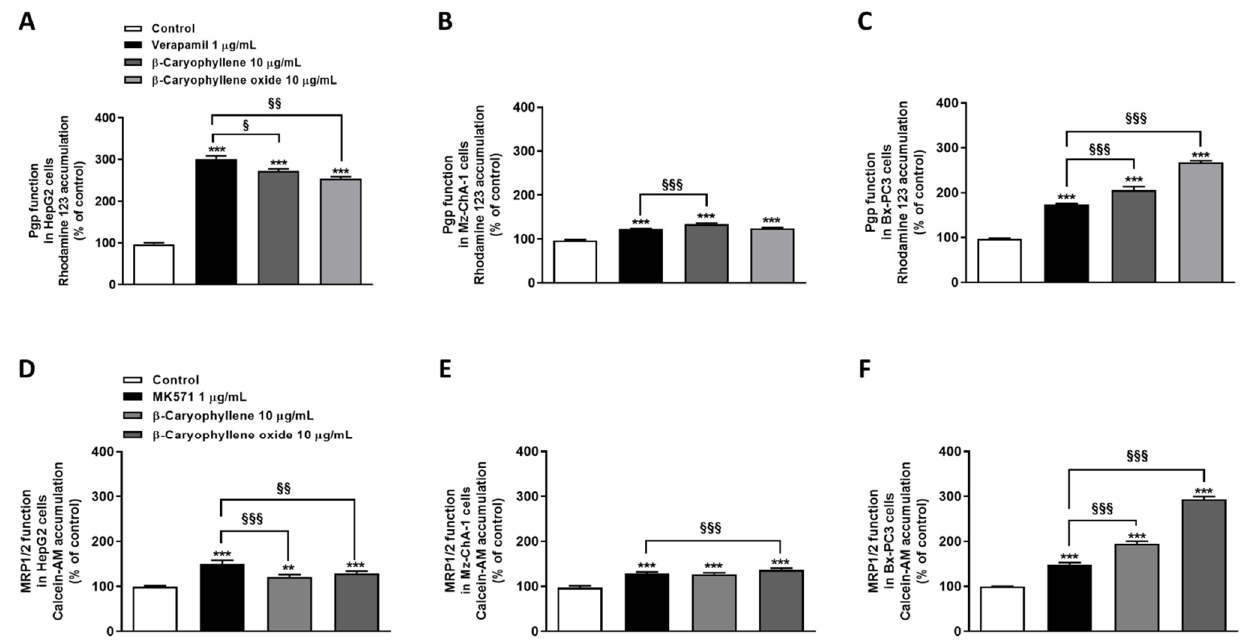
Figure 6. Effect of β -caryophyllene and β -caryophyllene oxide on the intracellular accumulation of rhodamine 123 and calcein acetoxymethyl ester (Calcein-AM) in HepG2 ( A , D ), Mz-ChA-1 ( B , E ), and Bx-PC3 ( C , F ) cells. ** p < 0.01 and *** p < 0.001 ( t -Student’s test) vs. control. § p < 0.05, §§ p < 0.01, and §§§